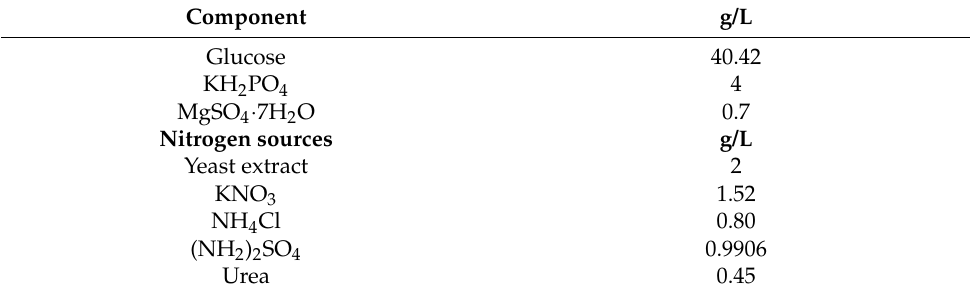
Table 1. Composition of the culture media with different nitrogen sources (C/N ratio 70:1).